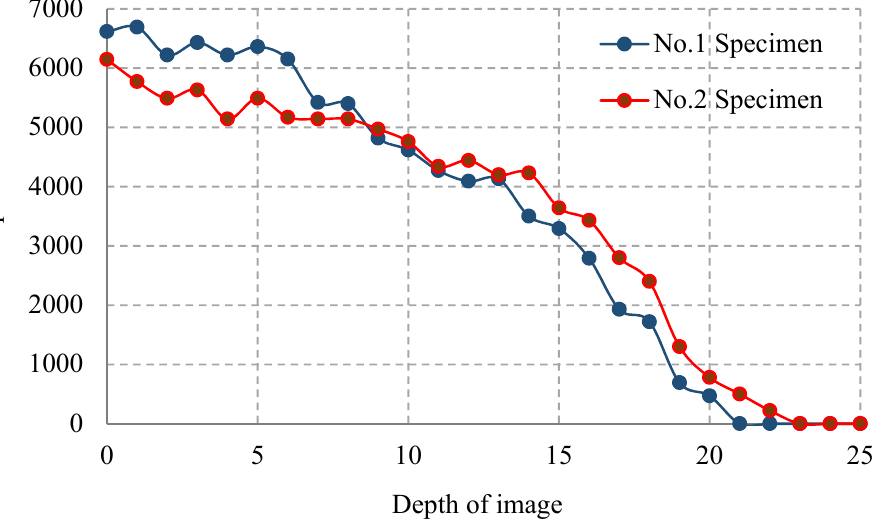
Figure 17. Crack pixel number variation along specimen depth direction.